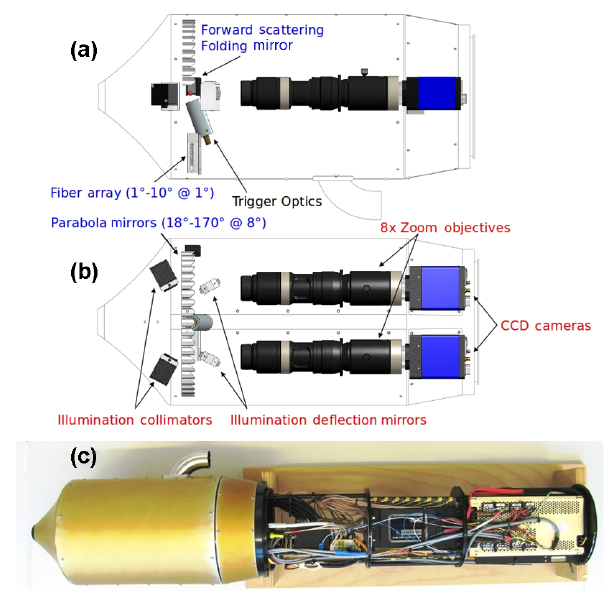
Figure 1. Schematic drawing of the optical detection units used in the PHIPS-HALO probe, (a) side view and (b) top view. The main components of the polar nephelometer and stereo-microscopic im- ager are labelled in blue and red, respectively. The trigger optics links the two components. (c) A real photo of the